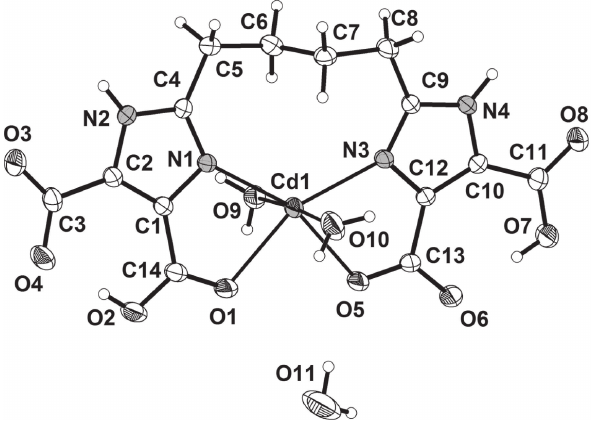
Table 1: Data collection and